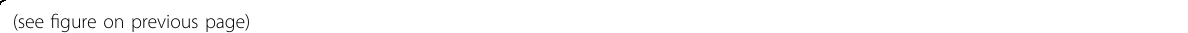
Fig. 5 STAT5 protects cells from pimozide-mediated cell death. a Cells were transfected with siRNA for STAT5A, STAT5B or both for 72 h. Lysates were analyzed STAT5 western blot. Knockdown of STAT5A or STAT5B reduced STAT5 protein levels, with greater reduction observed in cells transfected with STAT5B. b Cells were transfected with siRNA for STAT5A, STAT5B or both for 48 h, and subsequently subjected to fl ow cytometry following staining with propidium iodide. Knockdown of STAT5 protein did not affect cell cycle progression of OS cells. c Cells transfected with siRNA to STAT5A, STAT5B or both were treated with 10 µM pimozide. Cell proliferation measured by hexosaminidase assay demonstrated that knockdown of STAT5 reduced cell proliferation. d Cells were transfected with siRNA for STAT5A, STAT5B or both for 48 h and then treated with 10 µM pimozide for 24 h. Lysates were analyzed for STAT5 and Caspase 3 levels. Knockdown of STAT5A or STAT5B further enhanced pimozide mediated caspase 3 cleavage. e Cells were transfected with siRNA to STAT5A, STAT5B or both and then treated with pimozide were analyzed by fl ow cytometry following AnnexinV/PI staining. Pimozide treatment signi fi cantly induced cells to undergo necrosis and late apoptosis. However, knockdown of STAT5B reduced pimozide mediated necrosis resulting in further increase in